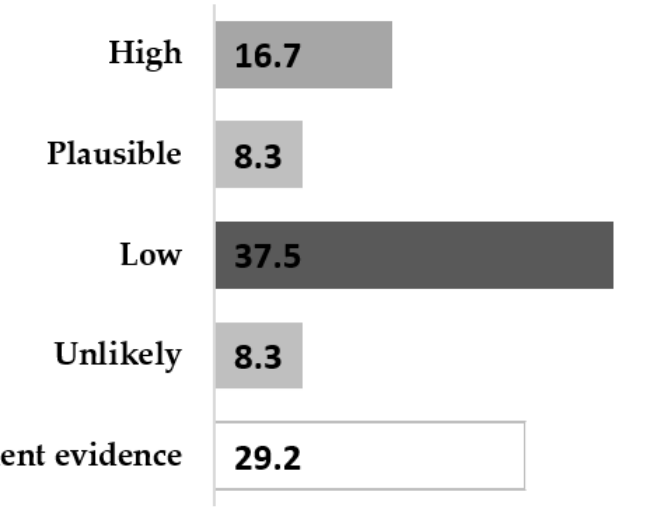
Table 1. Comments from the reviewed articles regarding the level of risk of SARS-CoV-2 infection through contact with contaminated surfaces.